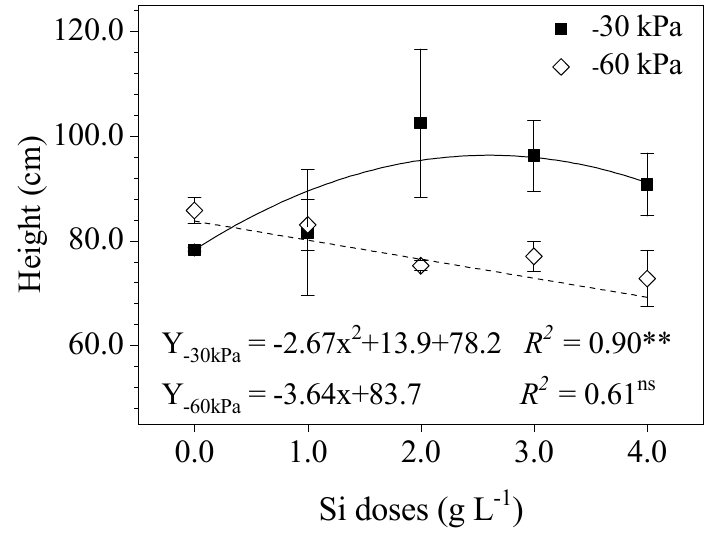
Figure 2. Plant height of the tomatoes under different water potentials in the soil in interaction with Si application at 48 DAT. (**) significant at 1% by F test; and ( ns ) not significant at 5% by F test.